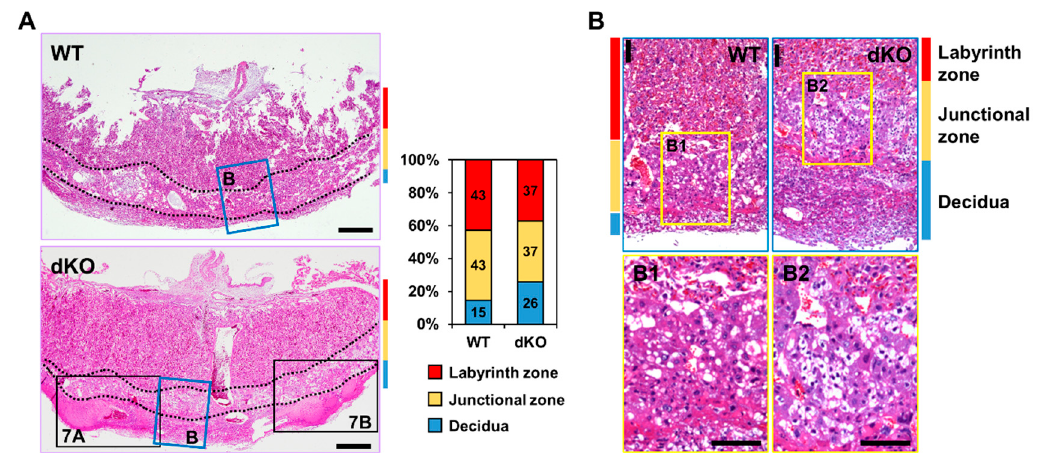
Figure 5. Histological analysis of WT and Stab1/2 dKO placentas. ( A ) H&E staining showing the overall shape and structure of placentas from WT and Stab1/2 dKO mice. Three layers of the placenta are indicated by colored lines, with red indicating the labyrinth zone, yellow indicating the junctional zone, and blue indicating the decidua. Quantitative analysis of the length of each placental zone. The percentages indicated for decidua, junctional zone, and labyrinth zone were quantified over the total length (100%) of the placenta. Scale bar, 500 µm. ( B ) High-magnification images of the blue rectangles in ( A ). (B1, B2) High-magnification images of the junctional zone in ( B ). Scale bar, 100 µm.